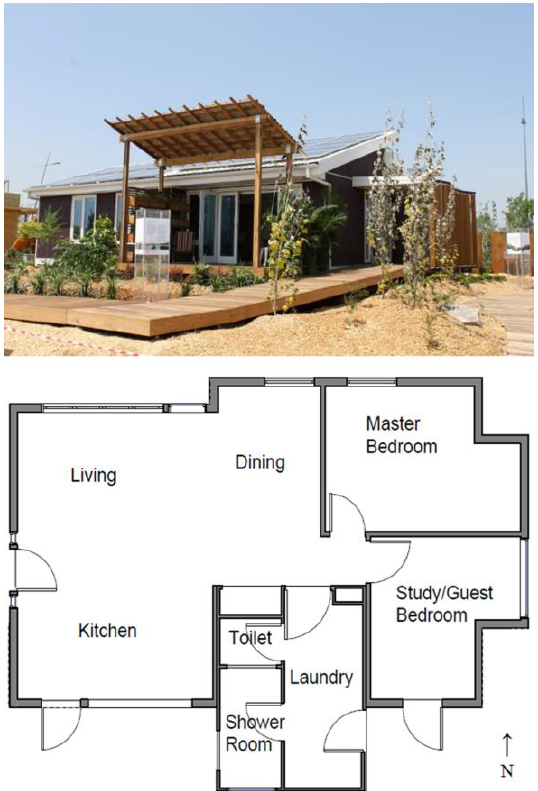
Figure 2. Case study building.